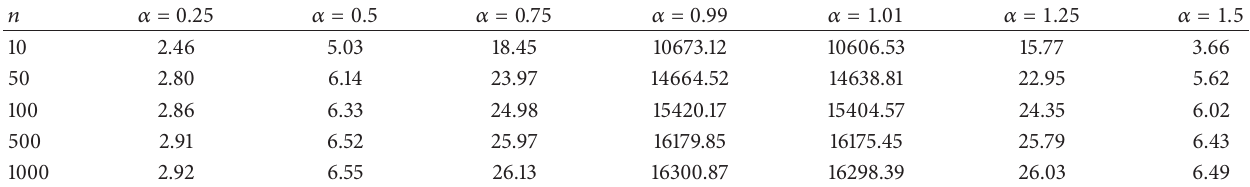
Table 2: Variance of empirical cumulative Tsallis entropy for different values of 𝑛 and 𝛼